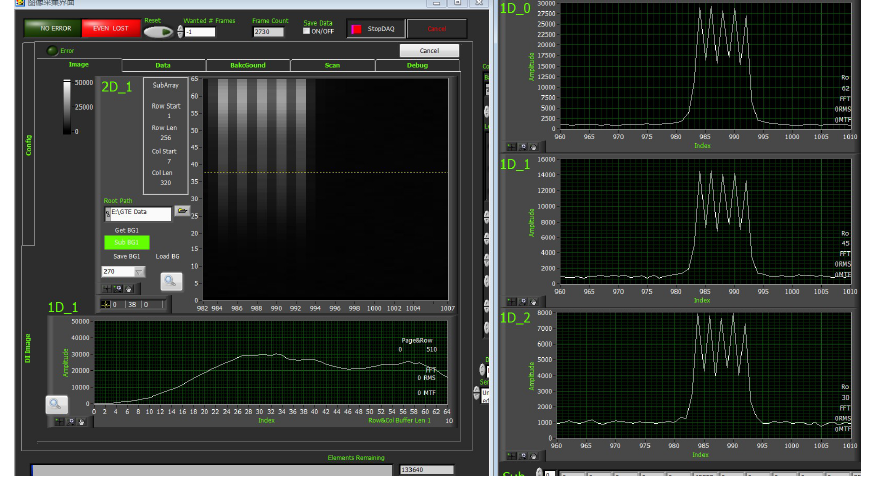
Figure 13. MTF calibration of three bands at the central FOV of high spatial mode (Band 30: MTF = 0.27, Band 45: MTF = 0.29, Band 62: MTF = 0.24).